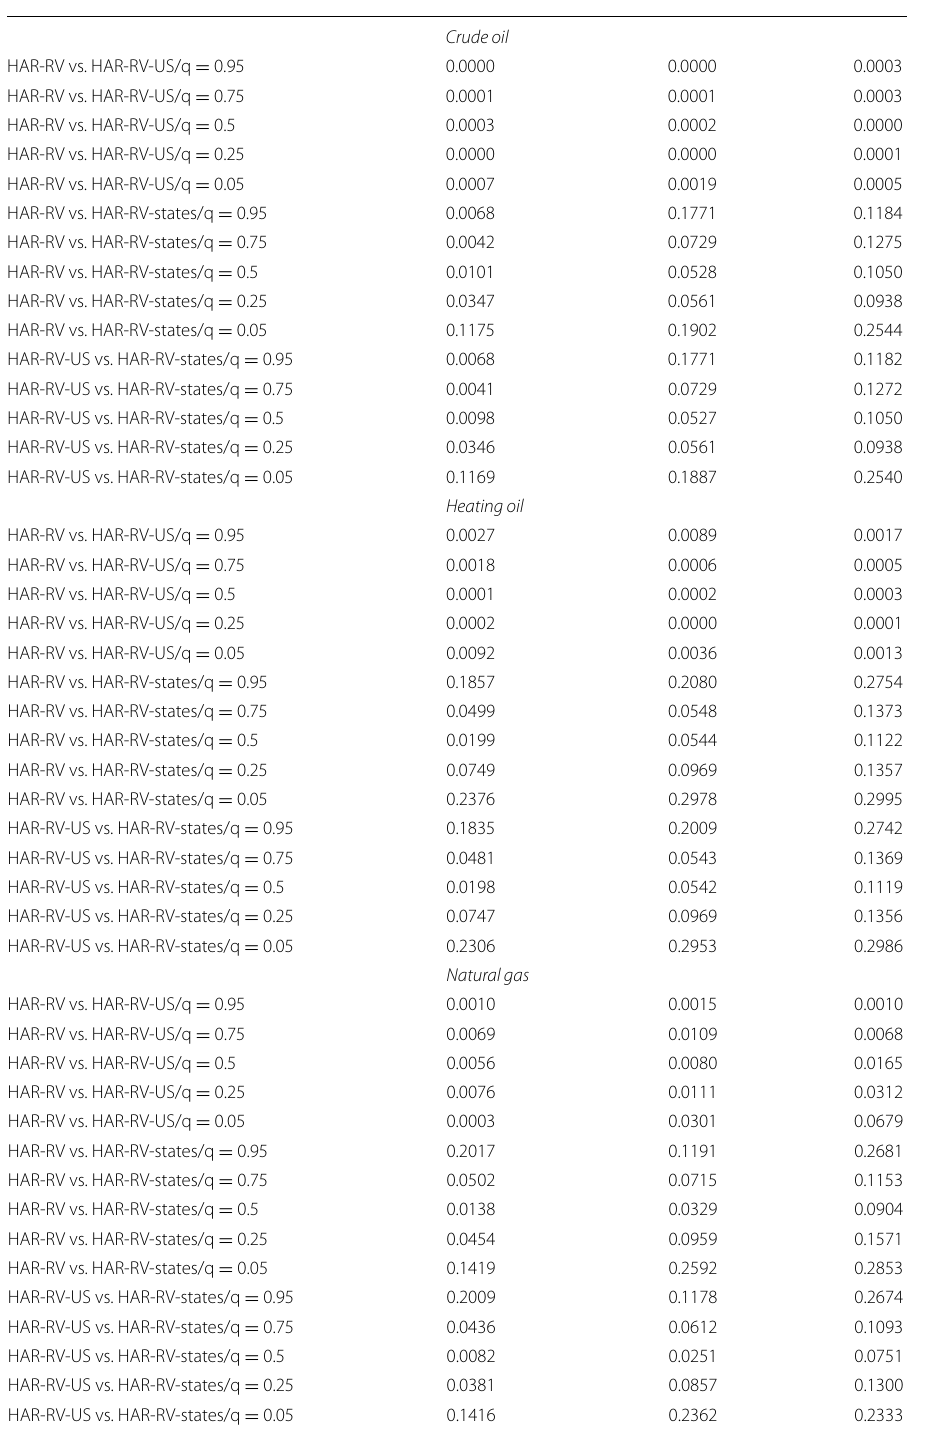
Table 7 Additional results based on intraday data